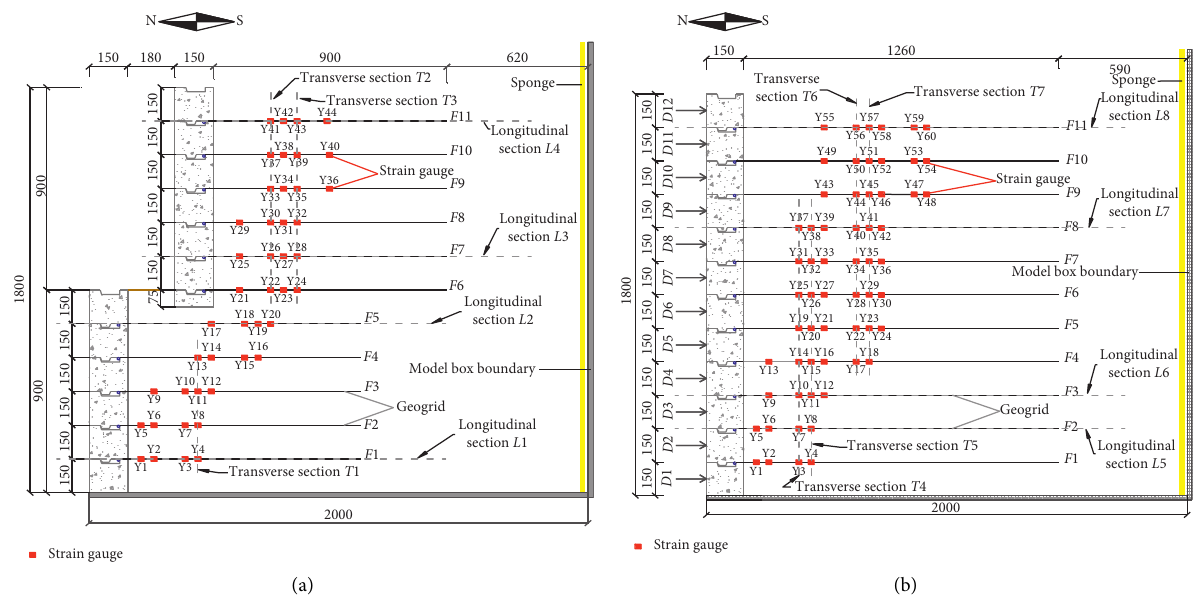
Figure 6: Shaking table model of RSRW. (a) Specimen 1. (b) Specimen